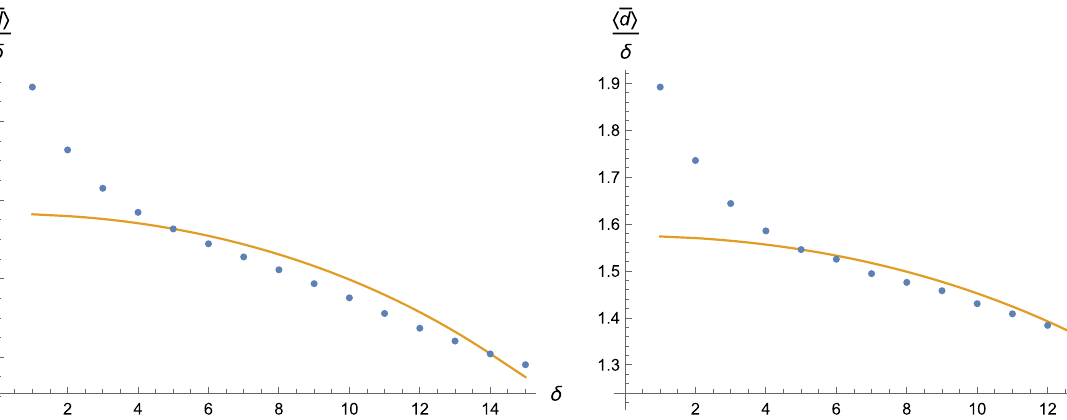
with radius ρ = 12 . 09 and ρ = 13 . 96 respectively are included for comparison (error bars are smaller than dot size)